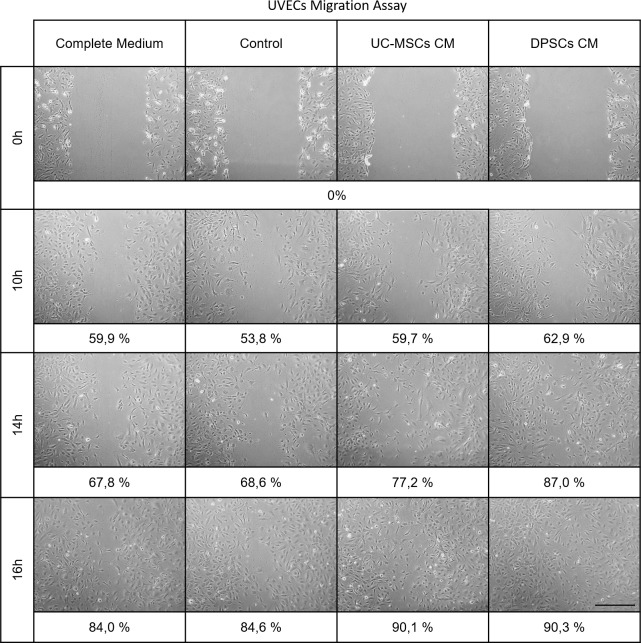
Migration assay of UVECs.At 0, 10, 14 and 16 hours in control or CMs supplemented media. Values are presented as percentage (%) of wound area coverage from the 0 hours baseline (scale bar = 200 μm).